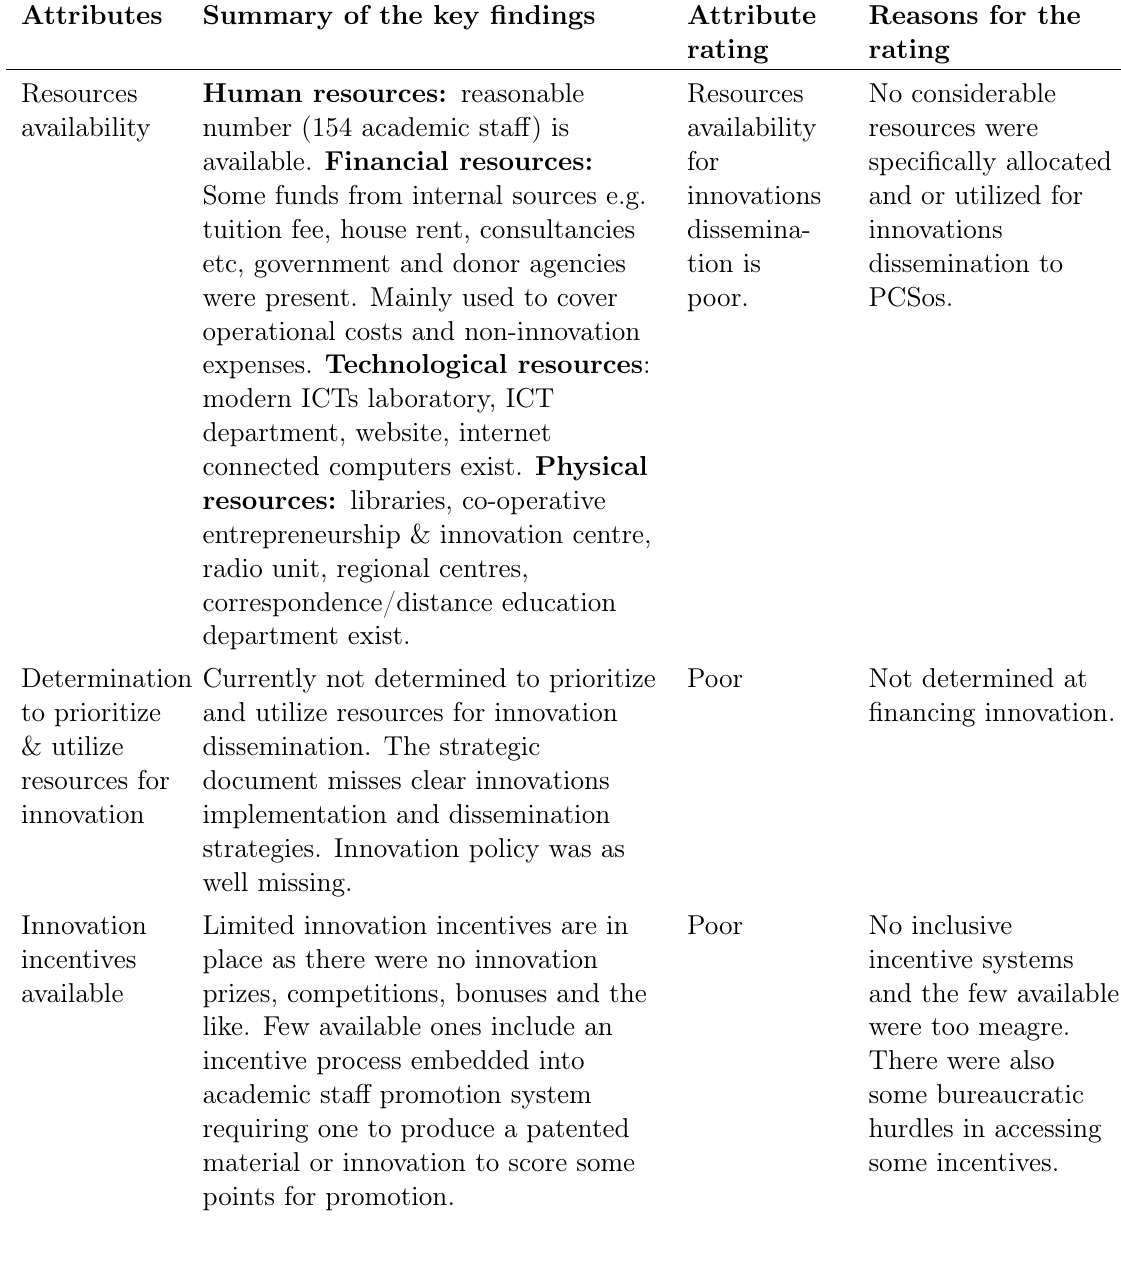
Table 1. MoCU resources capability attributes